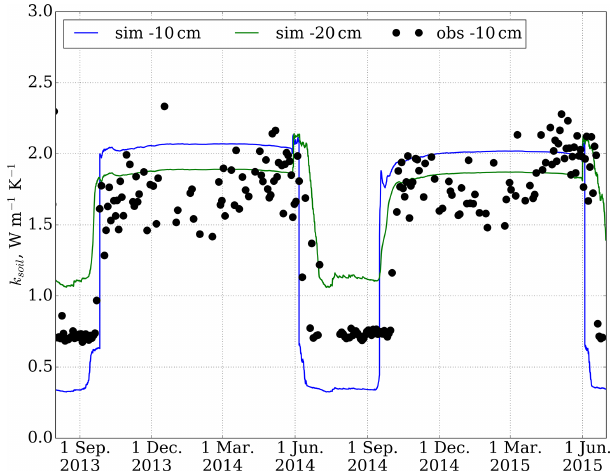
Figure 8. Evolution of the soil thermal conductivity measured at 10cm depth, and simulated (run wind ) at depths of 10 and 20cm.